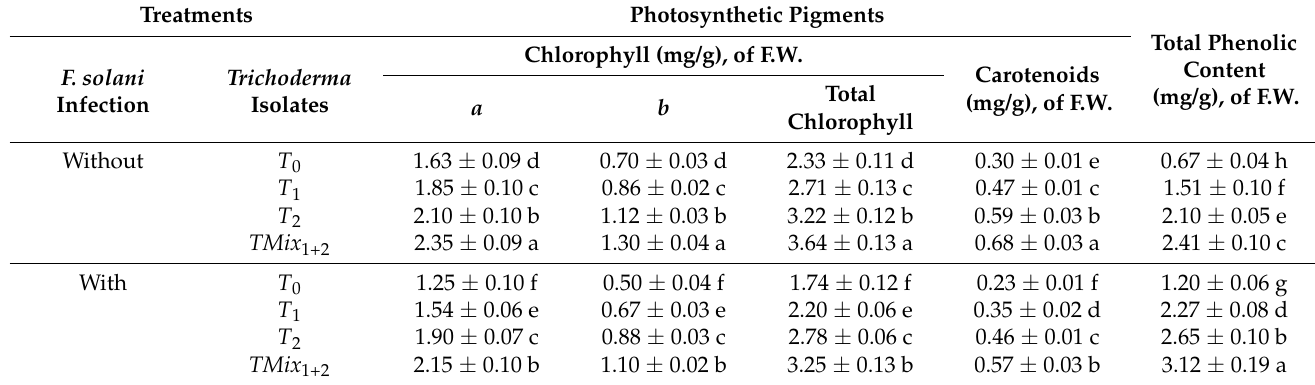
Table 4. Total phenolic content and photosynthetic pigments (chlorophyll a, b, and total carote- noids), of cherry tomato plants grown under greenhouse conditions with and/or without F. solani infested soil, as affected by different Trichoderma treatments.